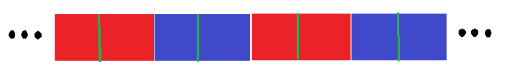
Figure 12 . The AlAdS boundary features alternating regions of two distinct vacuua, shown here as red and blue. Dots on each side indicate that the pattern may continue. Vertical cross-sections represent S D (cid:0) 2 -spheres for our solutions The transitions between vacuua (white vertical lines) are sources of domain walls. Our microcanonical path integrals include an energy constraint (vertical green lines) in each vacuum